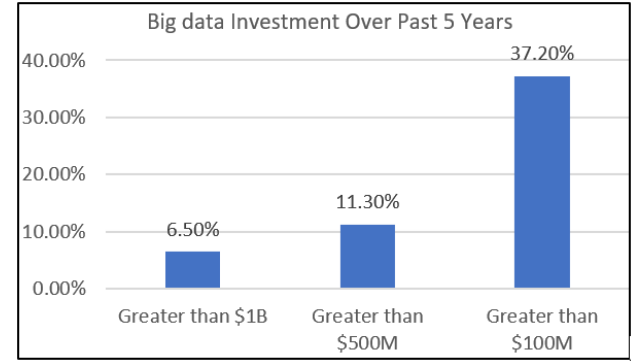
Figure 3. Big Data investment over the past five years [57].